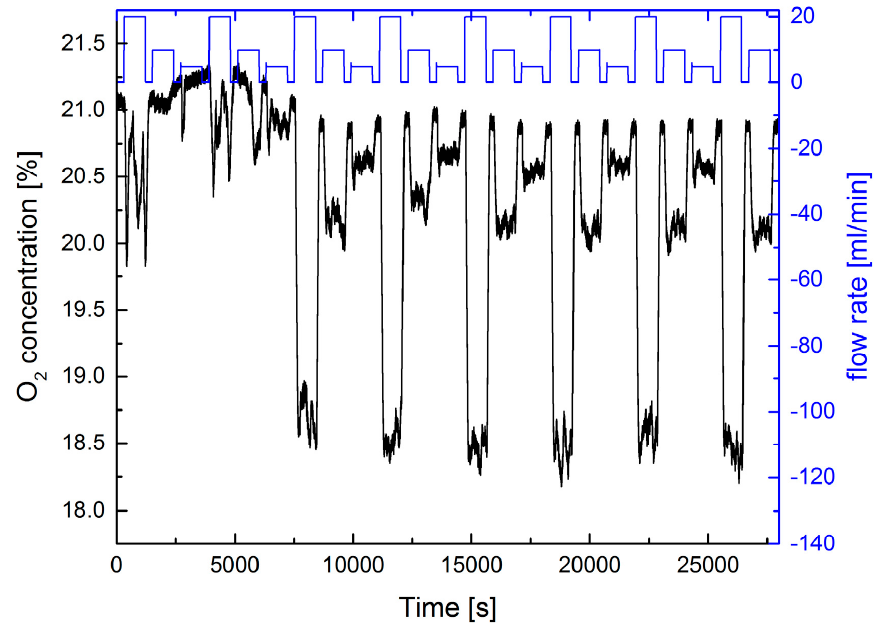
Figure 2. Extractive static measurement of the O 2 concentration using a 0.5 mm diameter tip in a distance of 10 mm from the leak plate. A pump rate of 100 mL/min was employed. The upper blue curve shows the variation of the N 2 -flux from the leak plate vs. time (right ordinate axis). Flux steps of 20, 10, and 5 mL/min were used.